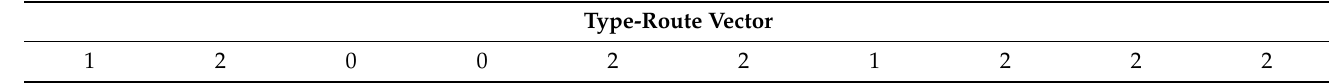
Table 4. Representation of a type-route vector.